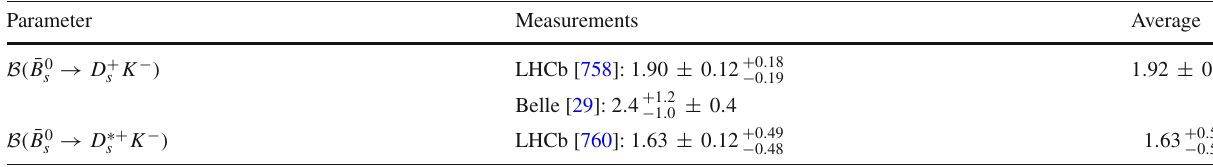
Table 187 Decays to a D